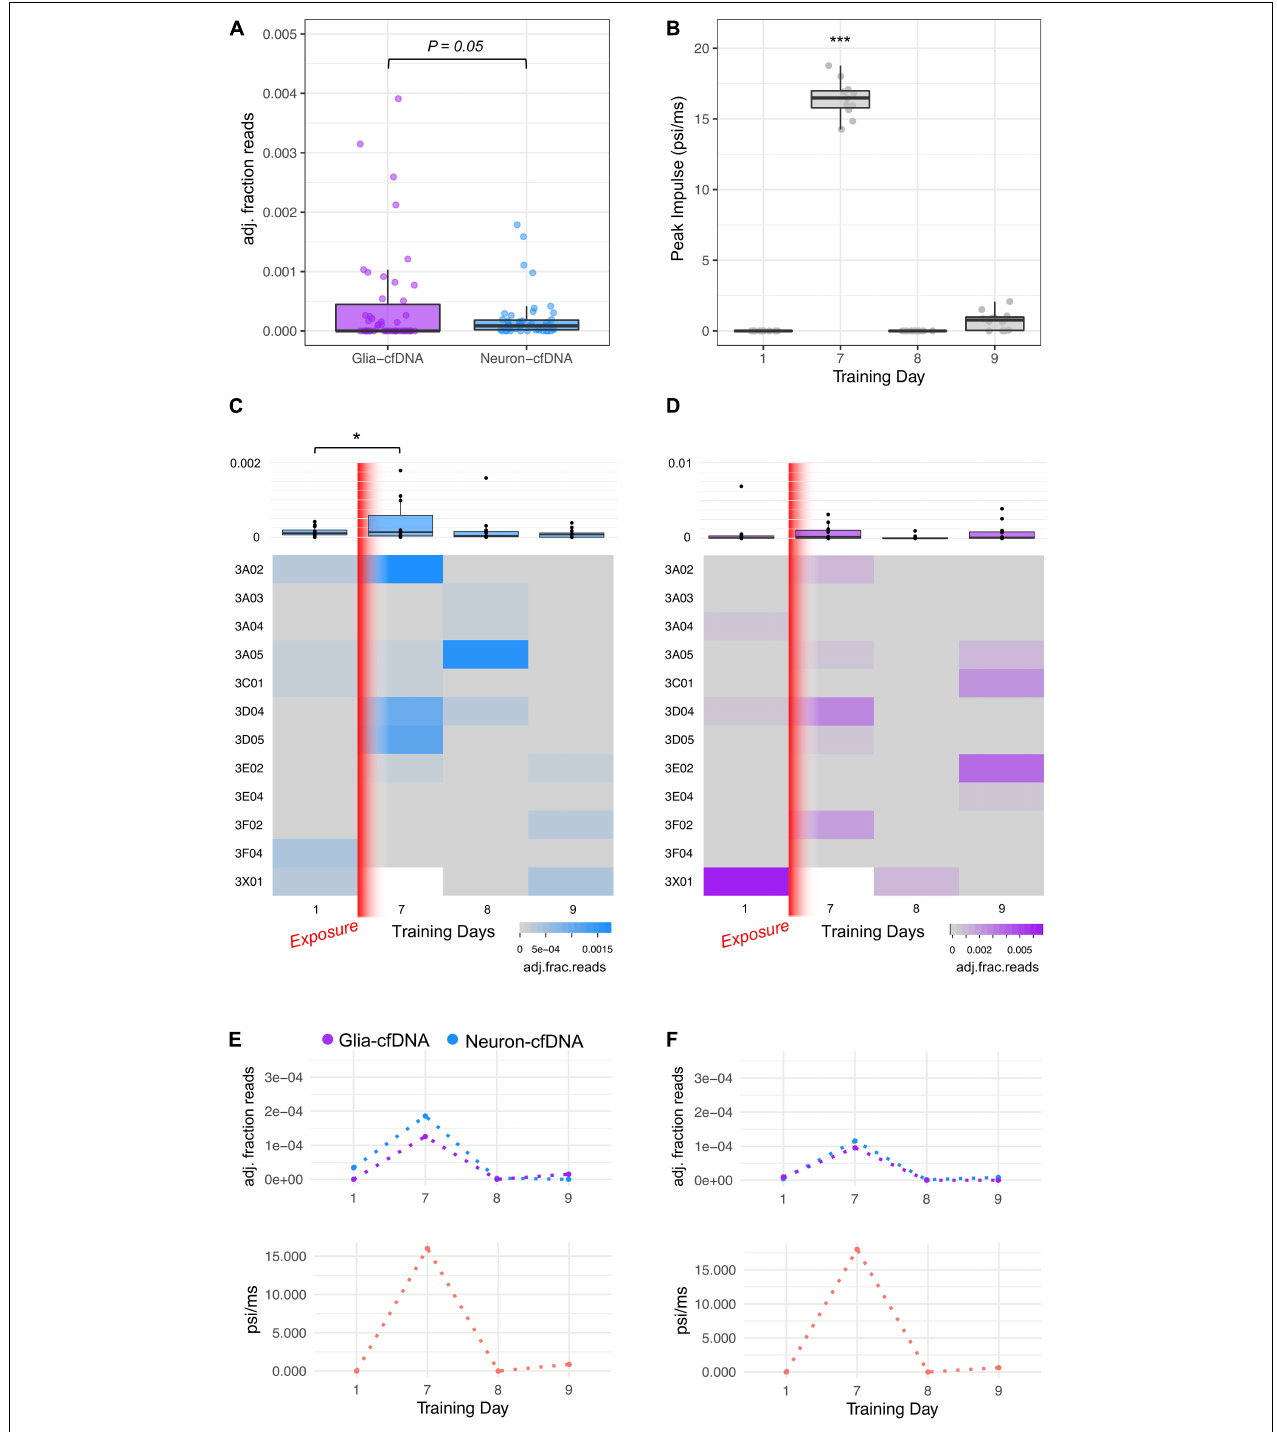
FIGURE 3 | Glia- and neuron-cfDNA measurements within 47 breacher blood plasma samples. (A) Boxplot of glia-cfDNA and neuron-cfDNA measurements within breacher samples, measured as adjusted fraction of sequencing reads (adj. fraction reads). (B) Boxplot of peak impulse exposure (psi/ms) measurements of breachers on training days 1, 7, 8, and 9 recorded by pressure monitoring devices mounted on each subject. (C) Heatmap and boxplots of the neuron-cfDNA measurements across days 1, 7, 8, and 9 of training. (D) Heatmap and boxplots of the glia-cfDNA measurements across days 1, 7, 8, and 9 of training. (E,F) Longitudinal glia and neuron-cfDNA measurements (top) and peak impulse exposure (psi/ms) of two breacher subjects with highest neuron-cfDNA levels. * p = 0.03 and *** p = 3.1 × 10 − 13 .